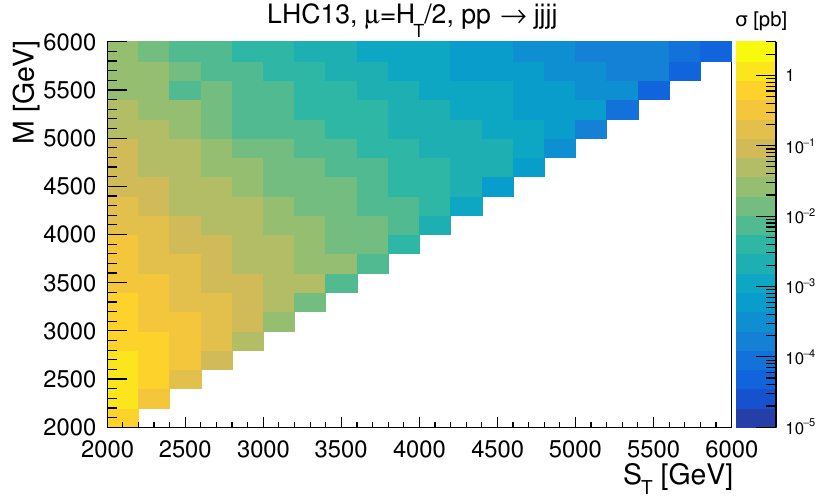
Figure 4 . Distribution of the centre-of-mass energy (M) as a function of S T for the production of four partonic jets at